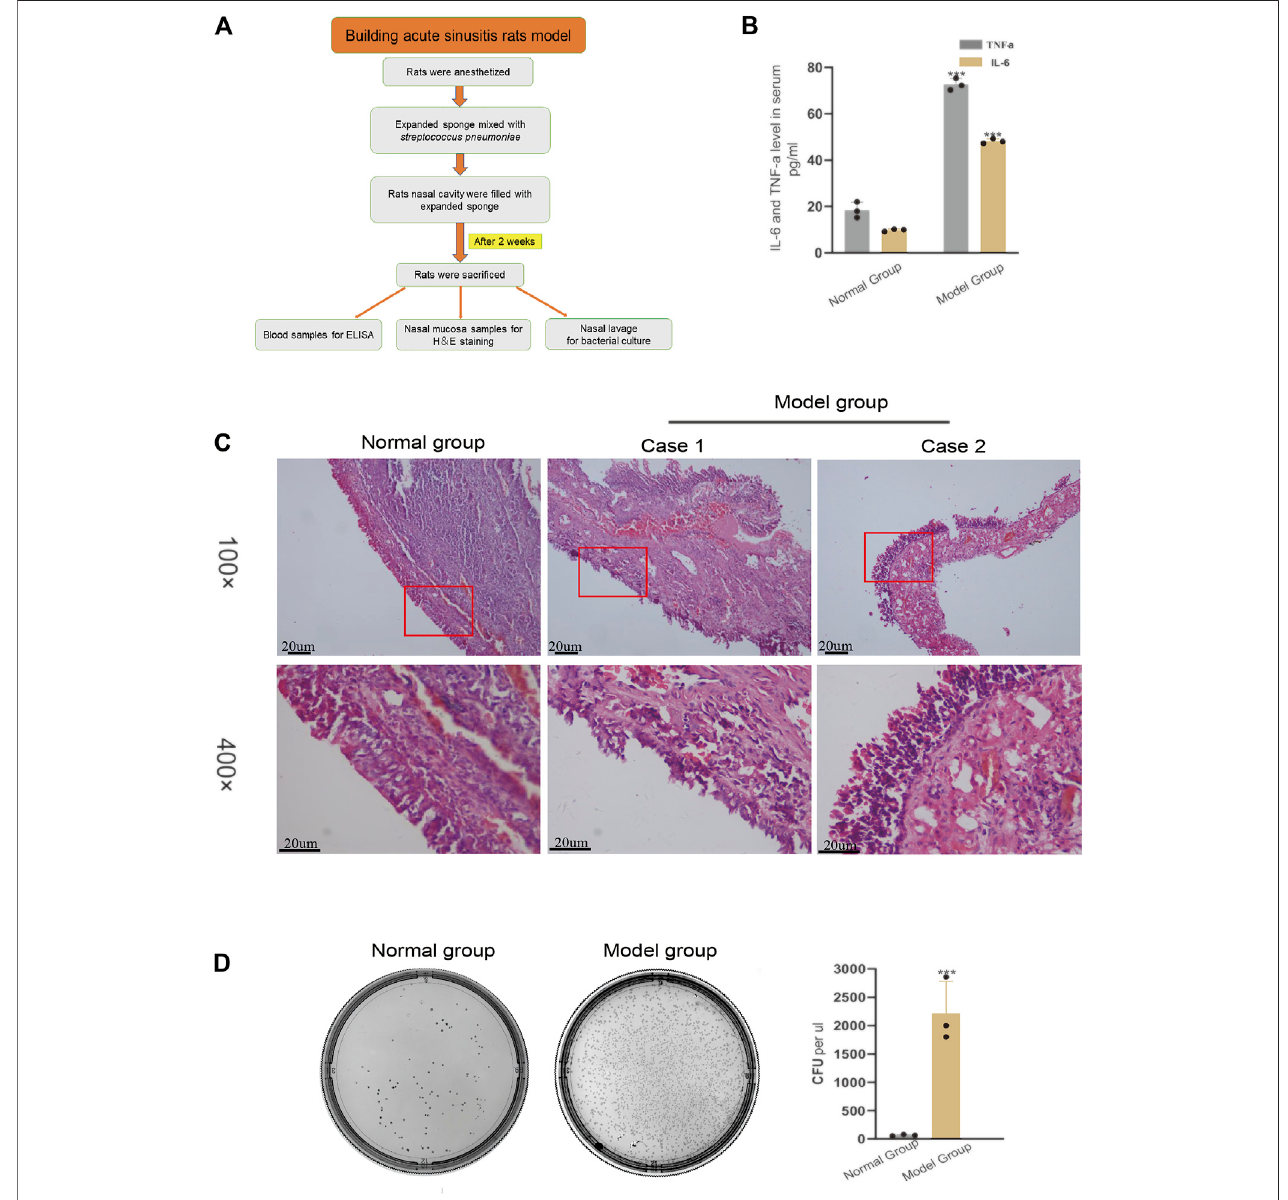
FIGURE 1 | Verifying the successful modeling of acute sinusitis in rats. (A) The basic fl ow chart of the experiment. (B) The relative expression of in fl ammatory cytokines TNF- α and IL-6 in the model group and the normal group rats by ELISA. (C) Comparison of H&E staining of nasal mucosa of rats in the model and normal groups. (D) Bacterial culture of nasal mucosal lavage fl uid of rats after 3 days. The left shows normal group rats and the right, model group rats. The experiment was repeated three times.